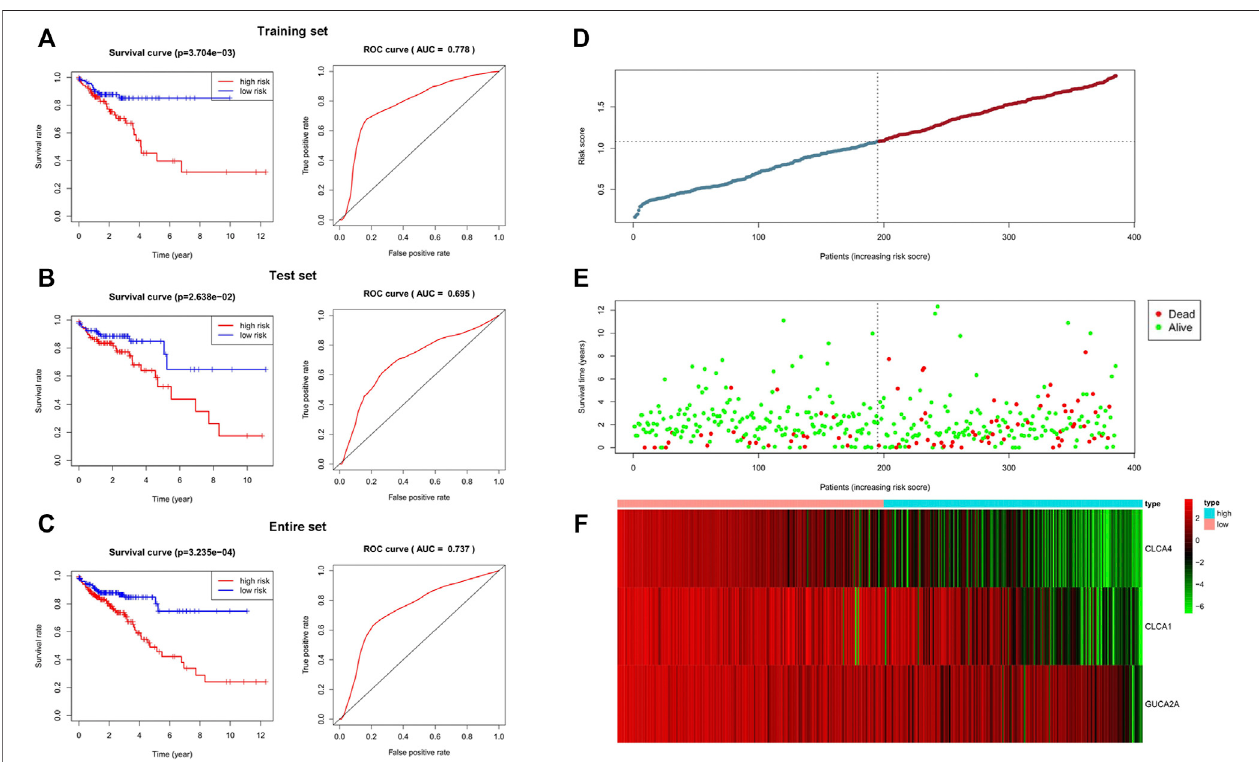
FIGURE5| Validationofthe3-genesignature.Inallthreesets,thereweresigni fi cantdifferencesinOSbetweenthehigh-riskgroupandthelow-riskgroup.Thearea under the ROC was 0.778 in the training set, 0.695 in the test set, and 0.737 in the entire set. The results showed that the 3-gene signature performed well in predicting the prognosis of colorectal adenocarcinoma. (A) Training set. (B) Test set. (C) Entire set. (D – F) Distributions of the 3-gene signature, survival status, and expression pro fi les of the three genes of entire sets.